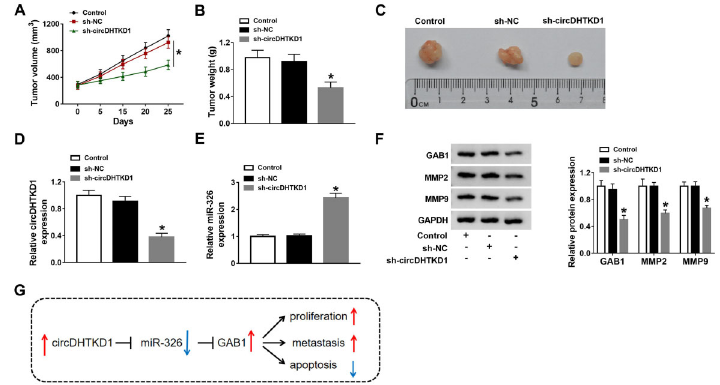
Figure 7. circDHTKD1 promoted oral squamous cell carcinoma (OSCC) progression in vivo by sponging miR-326 to regulate GAB1. A , Tumor volume was recorded after cell injection of control, sh-NC (negative control), and sh-circDHTKD1 groups every 5 days. Tumors were weighed after the excision from mice ( B ) and tumor images were photographed ( C ). D and E , The measurement of circDHTKD1 and miR-326 in tumor tissues was performed using qRT-PCR. F , Western blot was employed to determine the levels of GAB1, MMP2, and MMP9 proteins. G , A schematic fi gure of the current study. Three biological and three technical replicates were performed in expression detection. Data are reported as means ± SD. *P o 0.05 (one-way ANOVA followed by Tukey ’ s